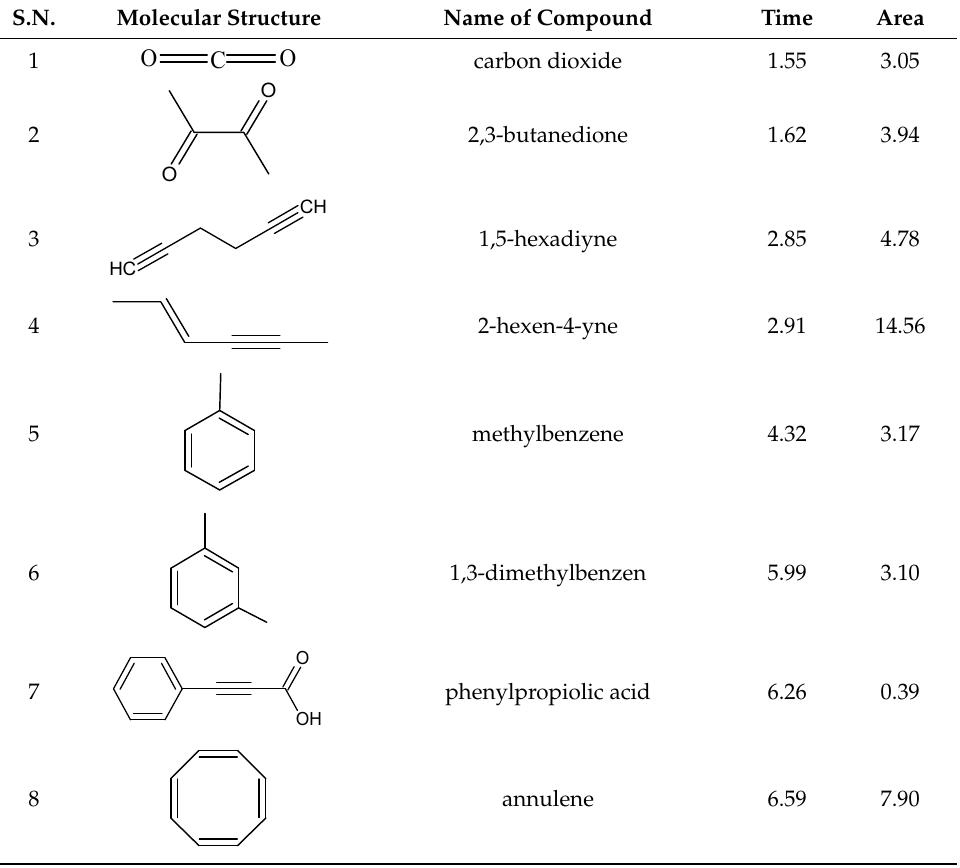
Figure 6. Py-GC-MS spectrum of the CAB-PL at 700 °C. Table 3. Pyrolysis products of the CAB-PL at 700 °C.